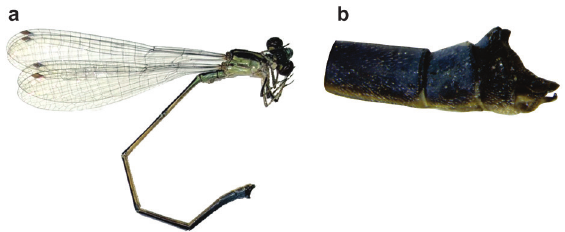
Figure 1 - a . Holotype, general view; b . Holotype, terminalia lateral